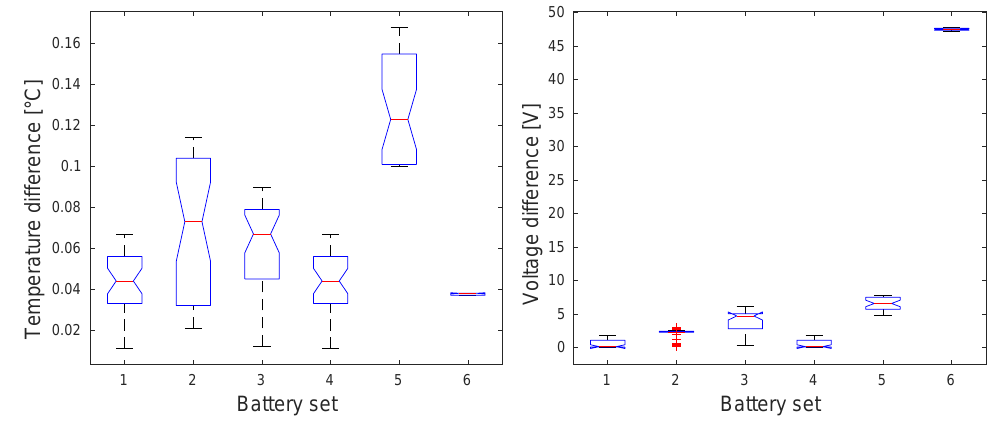
Figure 7. The analysis of variance of temperature ( left ) and voltage ( right ) ranges during discharging